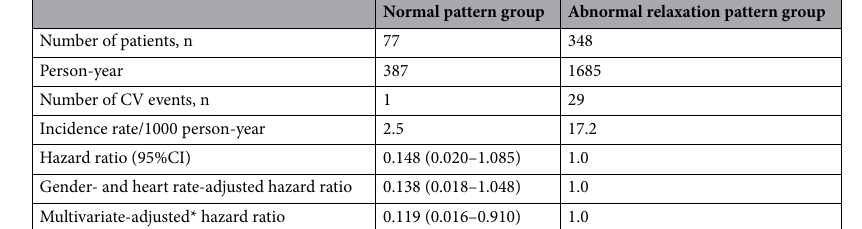
Table 5. Incidence rates and hazard ratios of cardiovascular events in relation to mitral inflow pattern. CI, confidence interval; CV, cardiovascular. *Adjusted for gender, heart rate, body mass index, and presence of